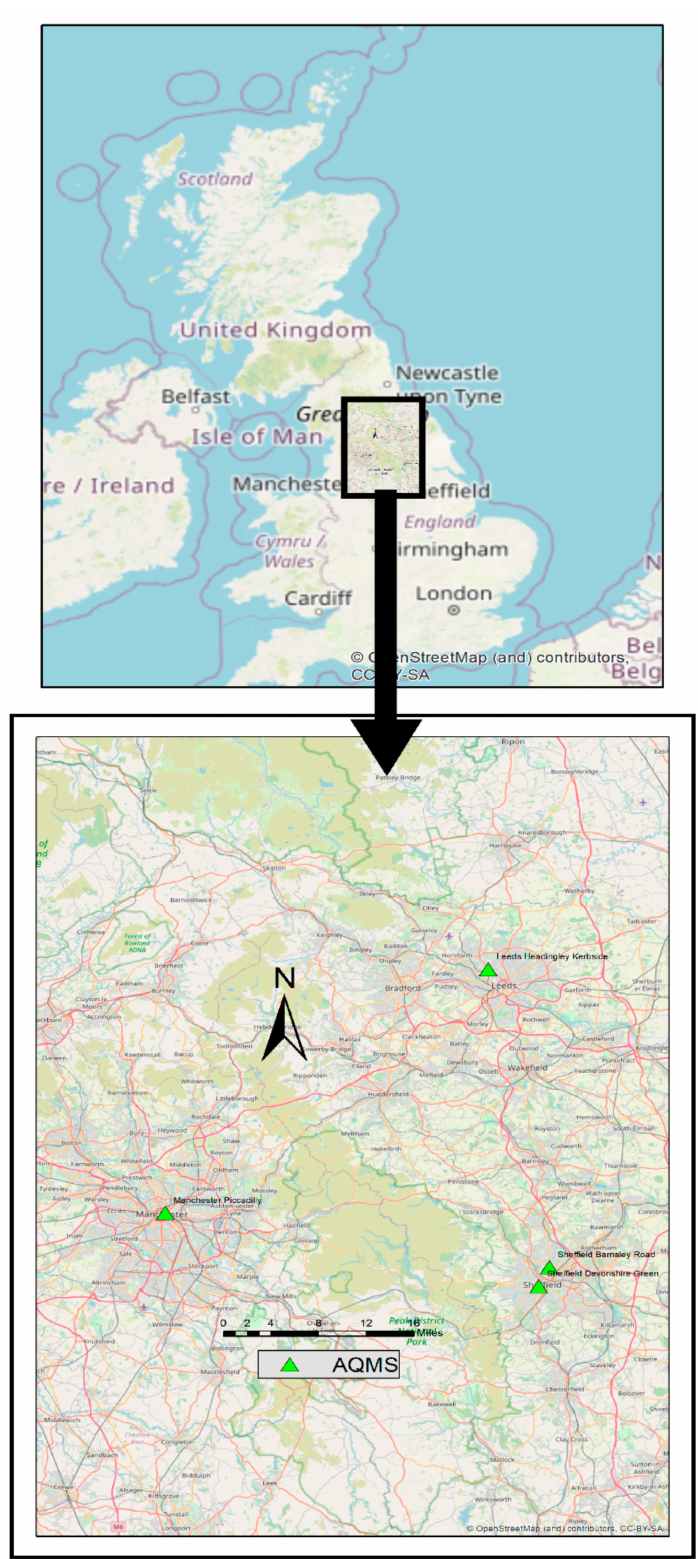
Figure 1. Locations of the air quality monitoring stations (AQMS) within the study area in the UK (Source: OpenStreetMap, developed in ArcGIS